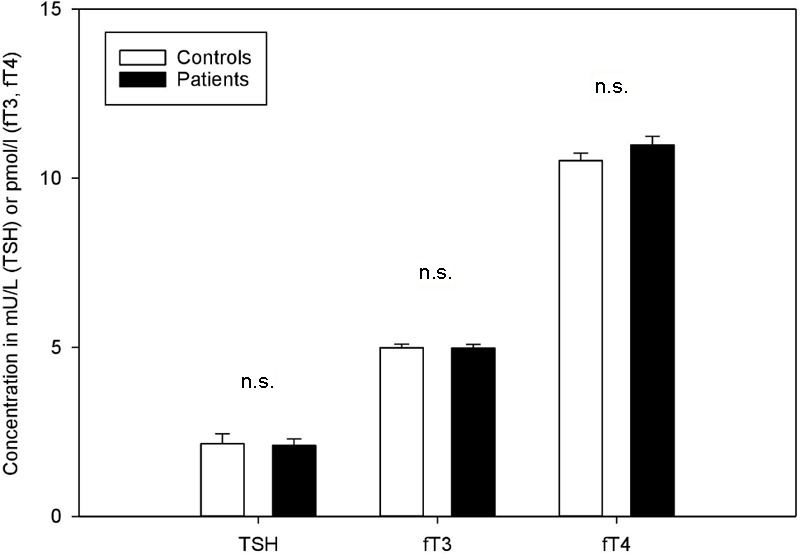
Thyroid parameters in patients with functional somatic syndromes (FSS) and healthy controls. Bars represent mean values and standard errors. Group comparisons did not yield any significant differences.